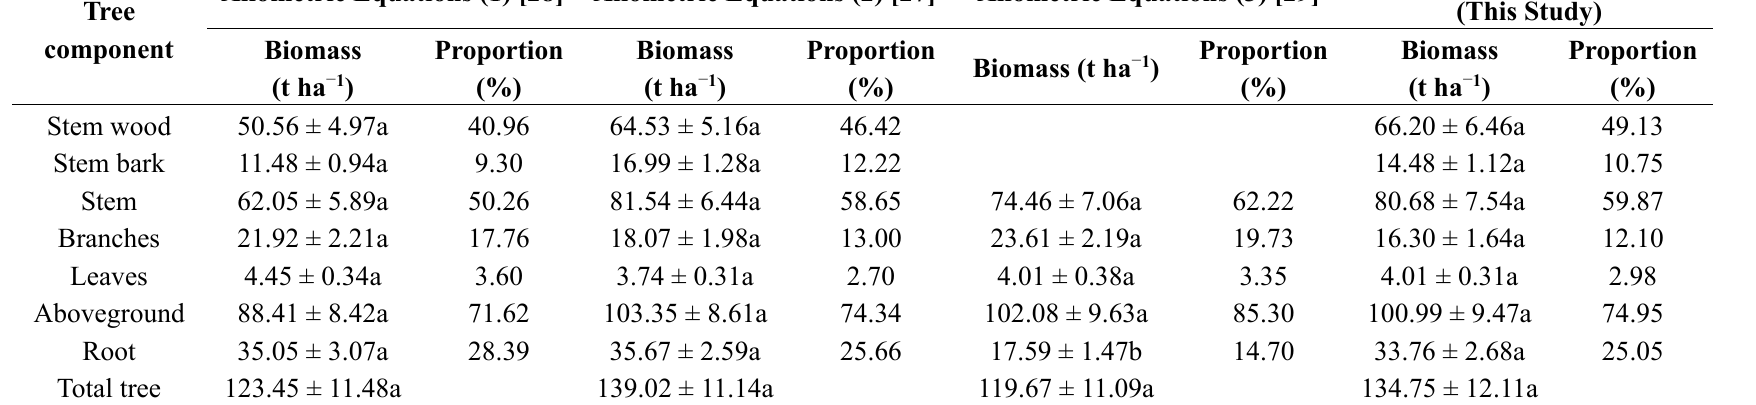
Table 2. Comparison of the biomass estimates of the various tree components by different allometric equations for a Chinese cork oak forest in the south slope of the Qinling Mountains,